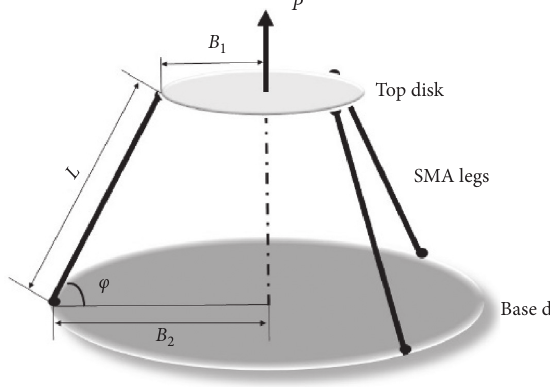
Figure 1: Three-leg supporter with shape memory alloys